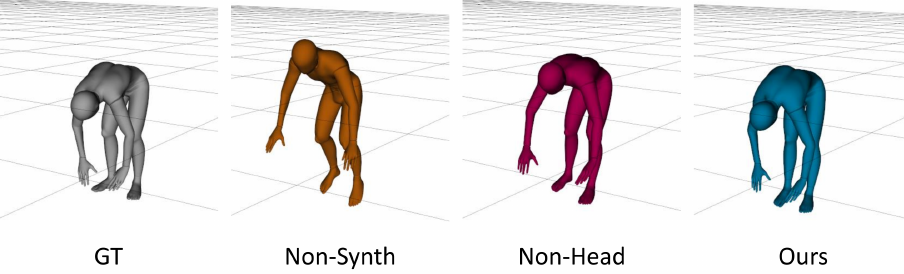
Figure 7. A comparison of the 3D model results. The figure shows the ground-truth and the real-time results of three types of models: the model that was trained excluding synthetic data (Non-Synth); the model that was trained excluding head height data (Non-head); and our